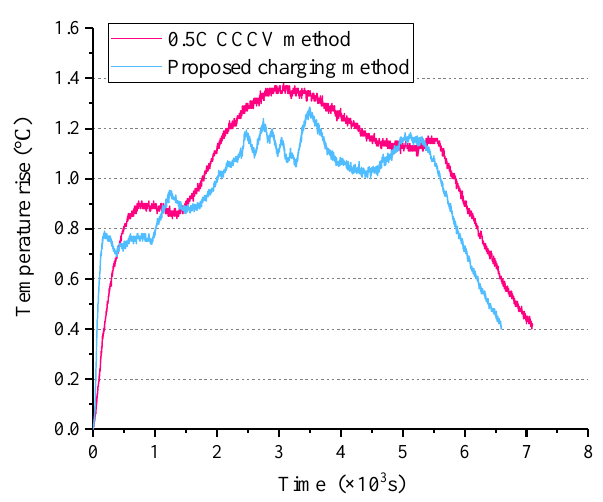
Figure 11. Surface temperature rise of the battery during the charging process.